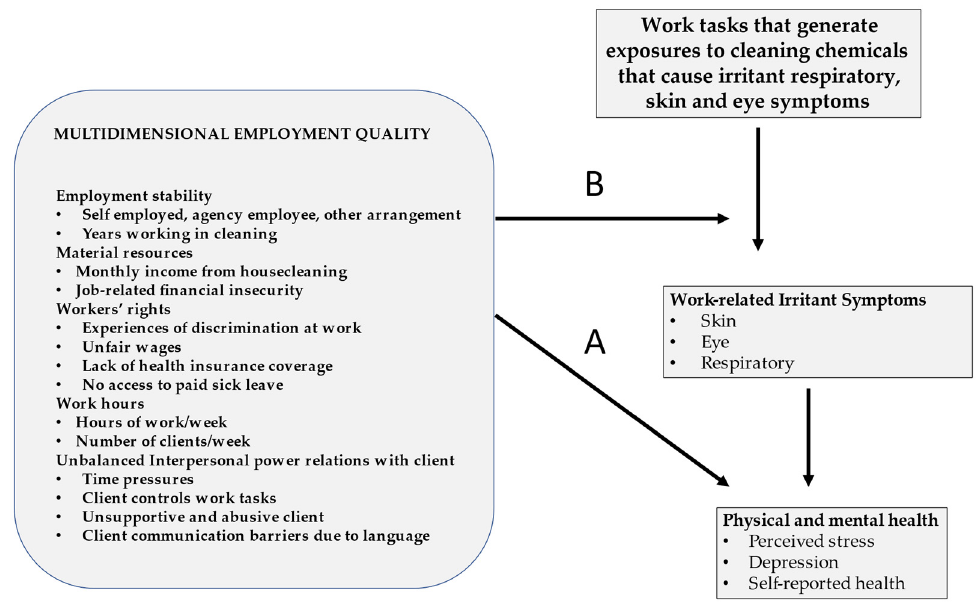
Figure 1. Theoretical Framework—Employment Quality (EQ), Workplace Chemical Hazards, and Health: Safe and Just Cleaners Study. Note: Pathway A hypothesizes a direct causal pathway between EQ and physical and mental health. Pathway B hypothesizes that the effects of EQ on health are mediated through work practices that generate chemical exposures causing irritant symptoms leading to poorer mental and physical health.